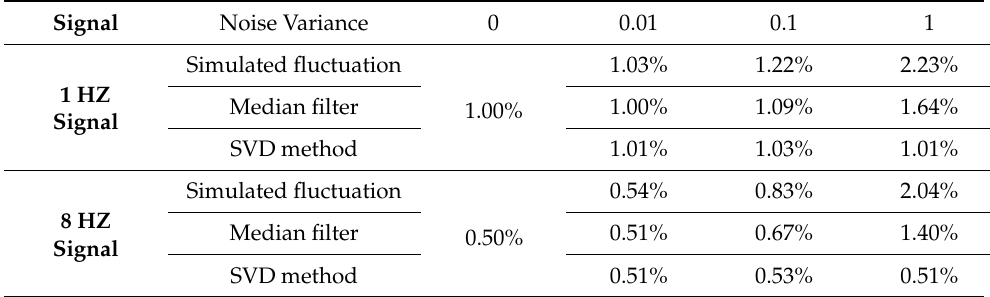
Table 5. Simulation results of 1 Hz and 8 Hz fluctuations.